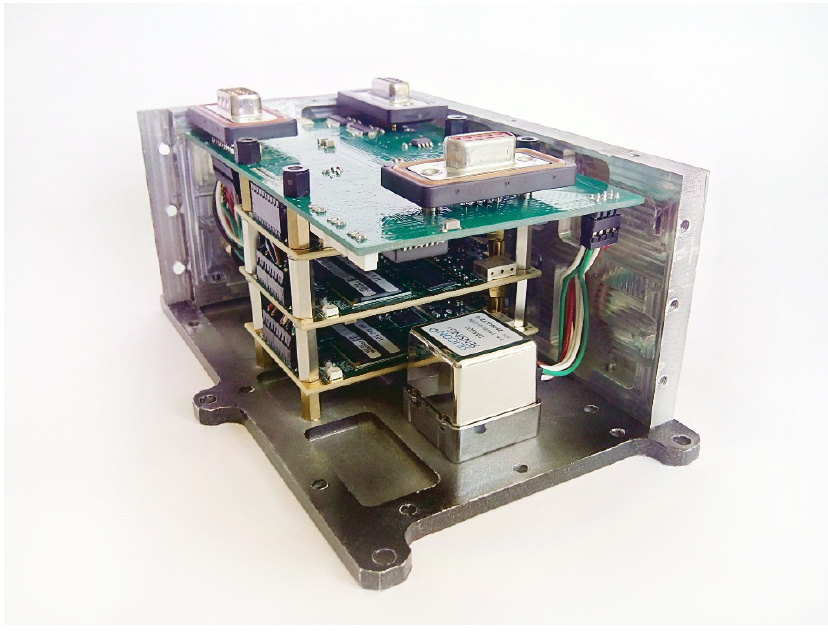
Figure 13. Small-sized integrated navigation system.